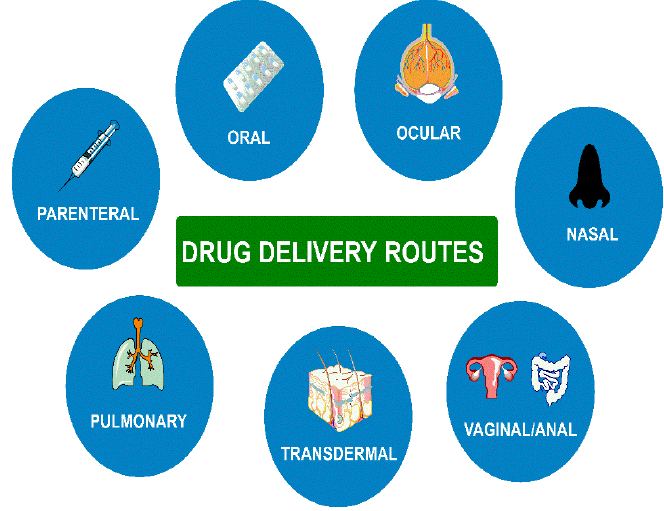
Figure 1. Schematic representation of drug delivery routes.